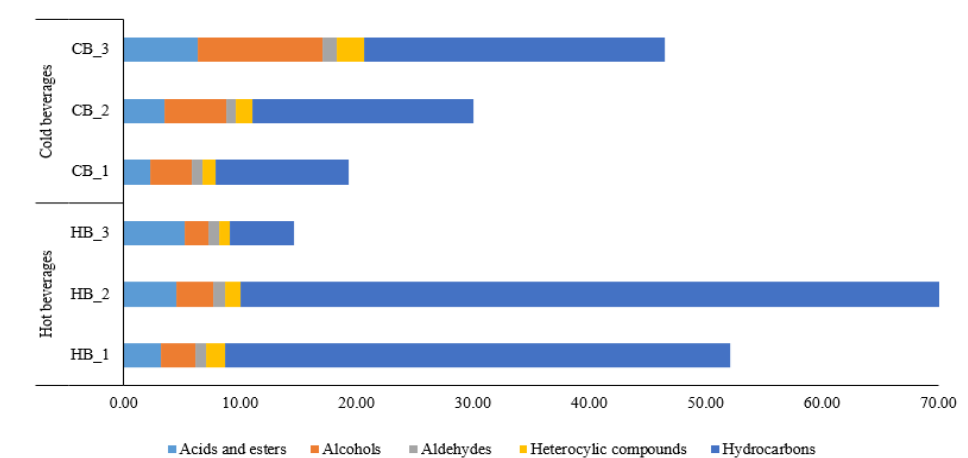
Figure 2. Total volatile components of hot- and cold-brewed beverages. HB_1, hot beverage 0.8 g/100 mL; HB_2, hot beverage 2 g/100 mL; HB_3, hot beverage 4 g/100 mL; CB_1, cold beverage 25 g/L; CB_2, cold beverage 50 g/L; CB_3, cold beverage 75 g/L. Hydrocarbons were identified as the dominant volatiles in the hot and the cold RSGW beverages in this study because of the high abundance of these compounds and their considerably higher relative peak area. Among the nine detected hydrocarbons, 2- methylpentane was established as the dominant odorant, showing the highest peak area (40.38 ± 3.98 for HB_2). This generation mechanism may be related to the higher thermal